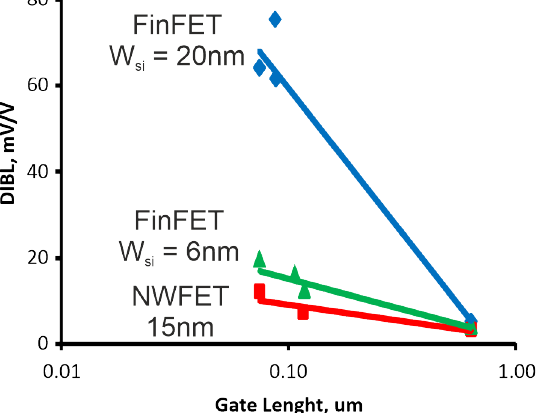
Figure 4. DIBL versus gate length L. NWFET has a lower DIBL than